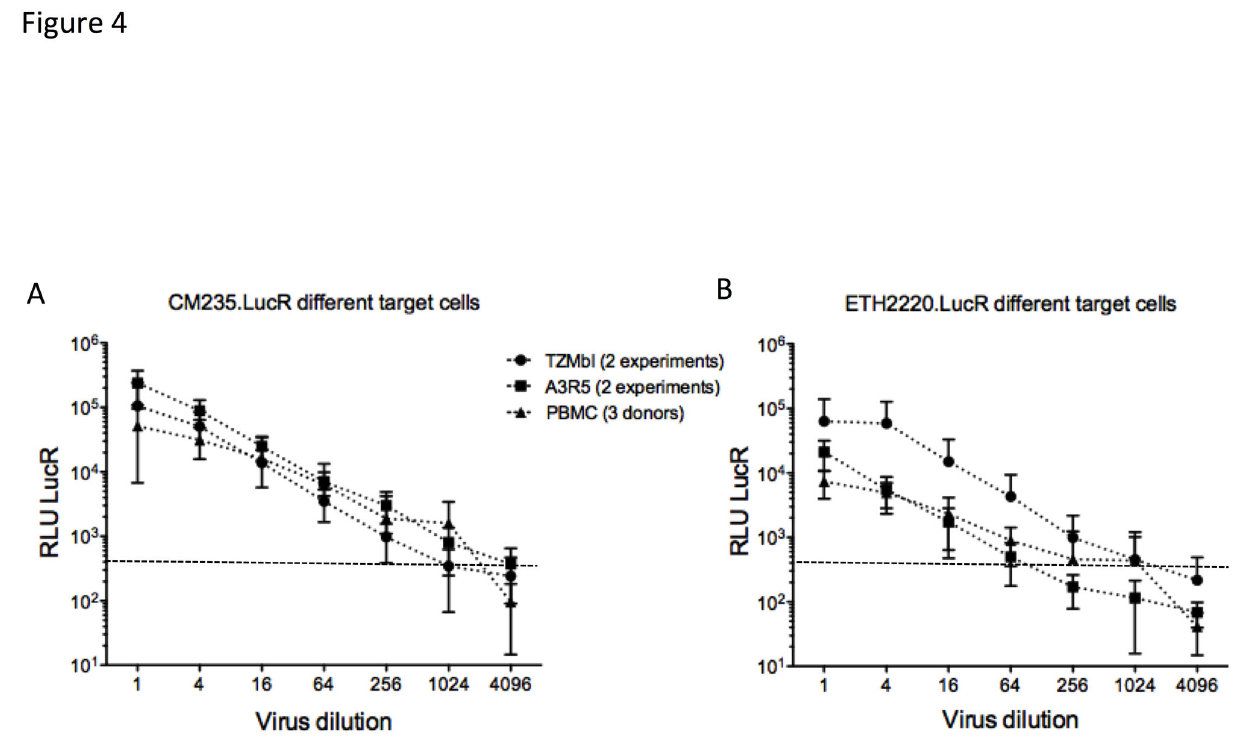
Figure 4. Titrations of CM235.LucR and ETH2220.LucR in different target cells. We also assessed infectivity of CM235.LucR (A) and ETH2220.LucR (B), in the cell lines TZMbl (two independent experiments) and A3R5 (two independent experiments), and in PBMC (three donors). RLU LucR was measured 72 hours after infection (dashed lines). Horizontal lines represent RLU cut off for LucR (dashed)